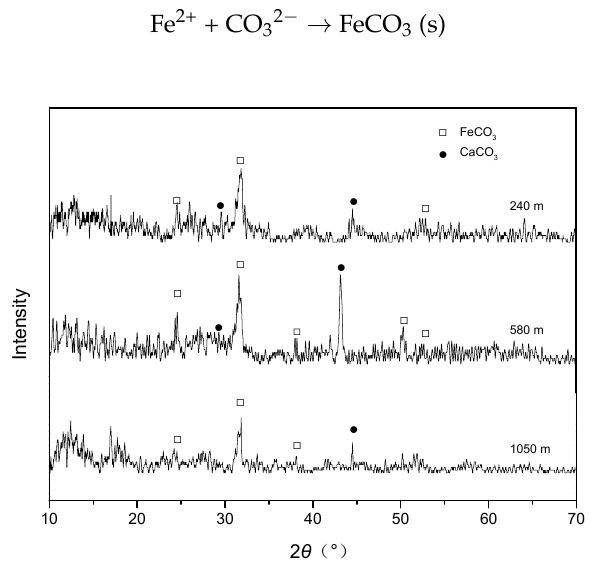
Figure 7. XRD spectra of the surface layers of the corroded samples.